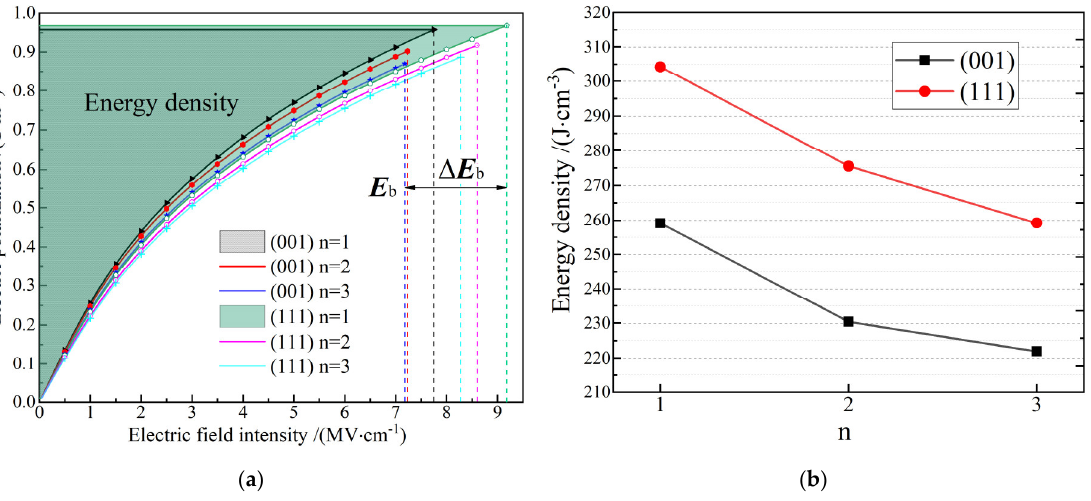
Figure 3. ( a ) P – E hysteresis curves where indicating breakdown field intensity by E b and energy density areas; ( b ) energy storage densities as an electric capacitor of (001) and (111) n*AlN/n*ScN superlattices ( n = 1, 2, 3). Table 2. Energy densities of the AlN/ScN superlattices in comparison to the recently reported non- linear dielectrics for energy storage capacitors, where the rGO and EDLC indicate reduced graphene oxide and electrochemical double-layer supercapacitor, respectively.